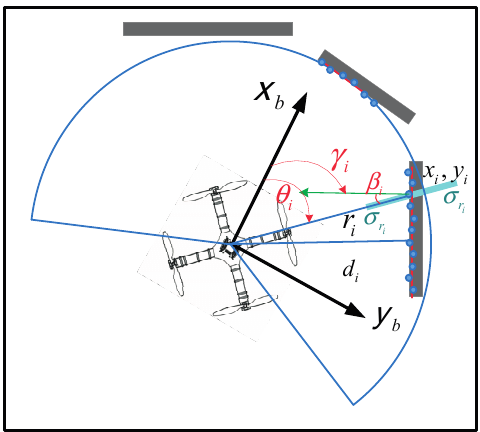
Figure 5. Uncertainty analysis of a laser range measurement. The blue points denote the measurement points in a single laser scan at time t . γ is the angle between the body axis and the vector normal of the surface at measurement point ( x i , y i ), and β i is the angle form the vector normal to the measurement direction. d is the distance from the origin to the line segment i